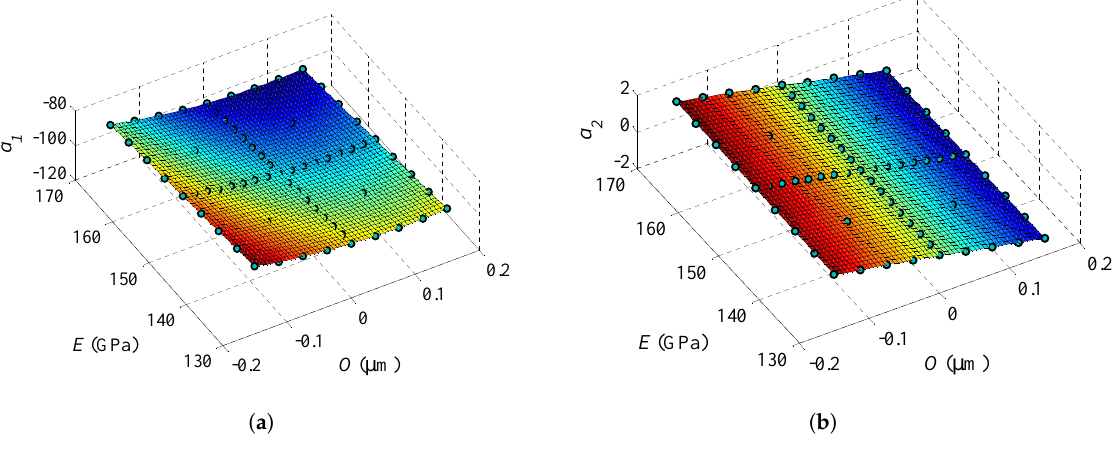
Figure 5. Dependence on O and E of the two interpolation functions ( a ) ˆ α 1 and ( b ) ˆ α 2 used to weight the effects of the POMs retained in the surrogate